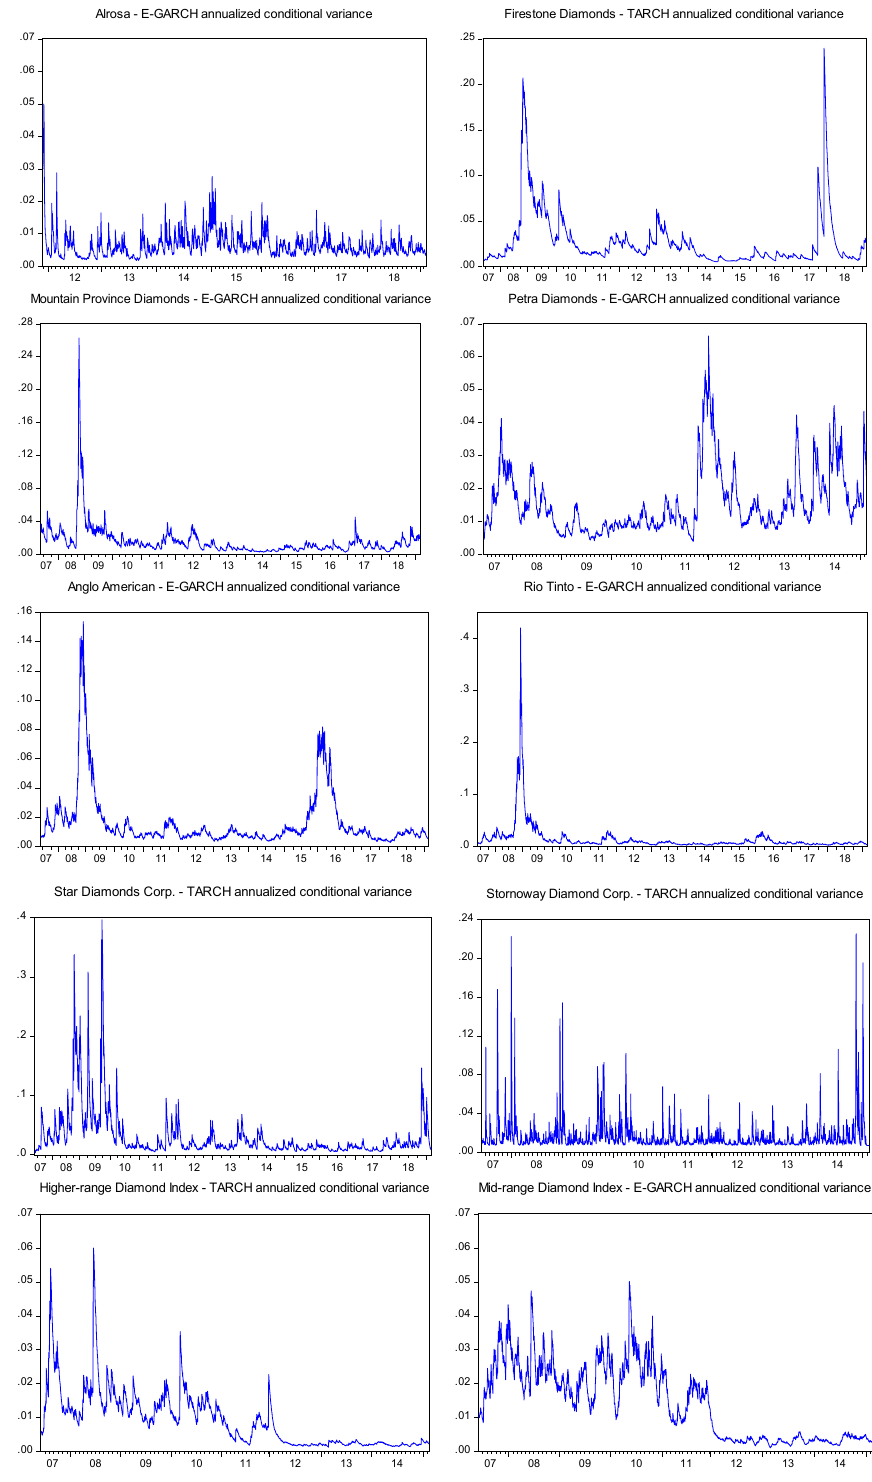
Figure 7. GARCH conditional variances of log returns of diamond stocks and indices. Notes: The